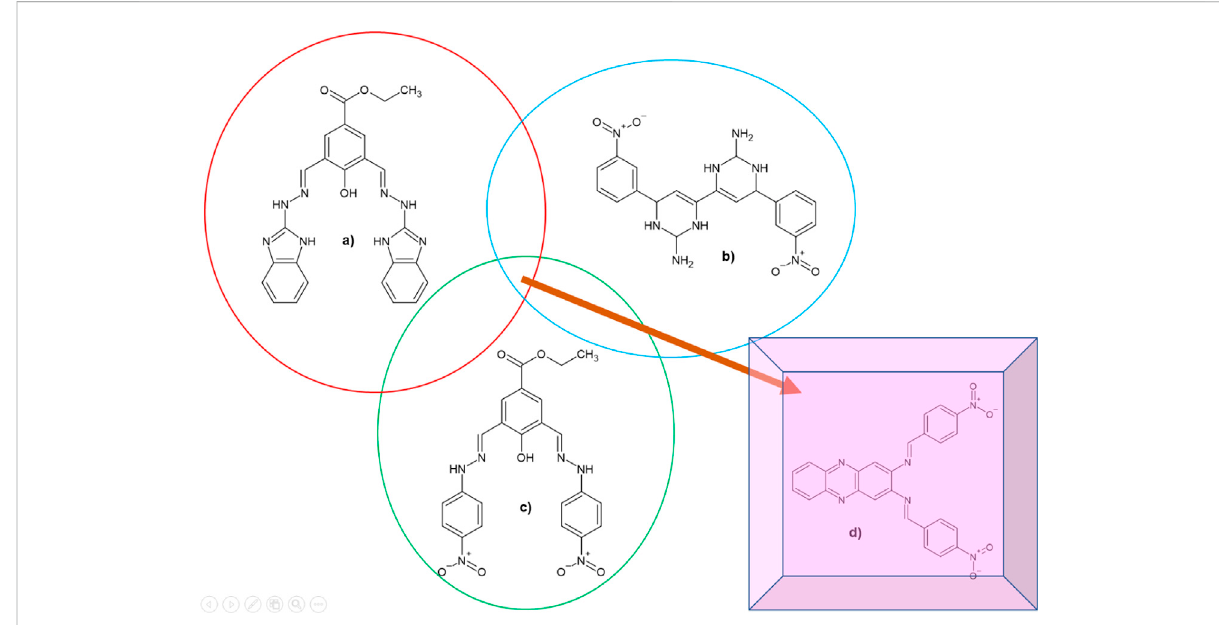
FIGURE 1 2Dchemicalstructuresof (A) theleadcompound( 1 ;IC 50 =13.1 µM), (B)1855 (IC 50 =29.41 µM), (C)22a (IC 50 =14.58 µM),and (D) thesuggested compound to be designed by extracting the common functional group in the previous known active compounds against DENV2 NS2B-NS3